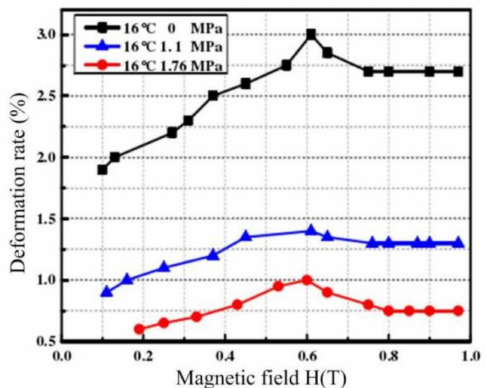
Figure 11. The relationship between deformation rate and magnetic